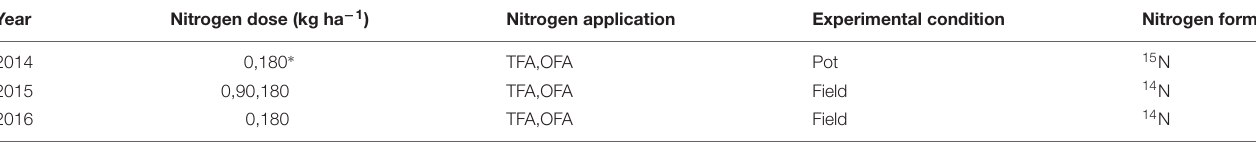
TABLE 2 | The experimental design of the three years.